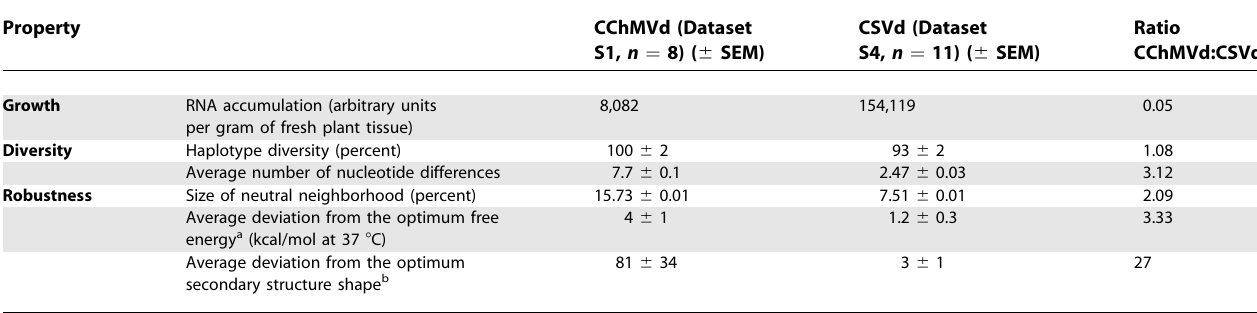
Table 1. Replication, Diversity, and Robustness Characteristics of CChMVd and CSVd Quasispecies